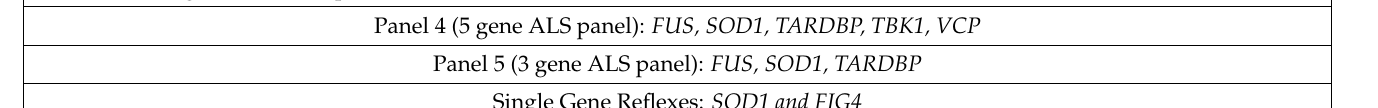
Panel 3 (11 gene dementia panel): APP, CHMP2B, FUS, GRN, MAPT, PSEN1, PSEN2, SQSTM1, TARDBP, TREM2, UBQLN2 Panel 4 (5 gene ALS panel): FUS, SOD1, TARDBP, TBK1, VCP Panel 5 (3 gene ALS panel): FUS, SOD1, TARDBP Single Gene Reflexes: SOD1 and